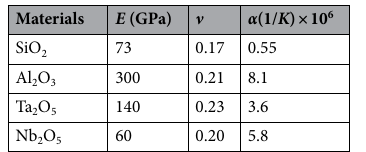
Table 2. Mechanical parameters of four types of different coating